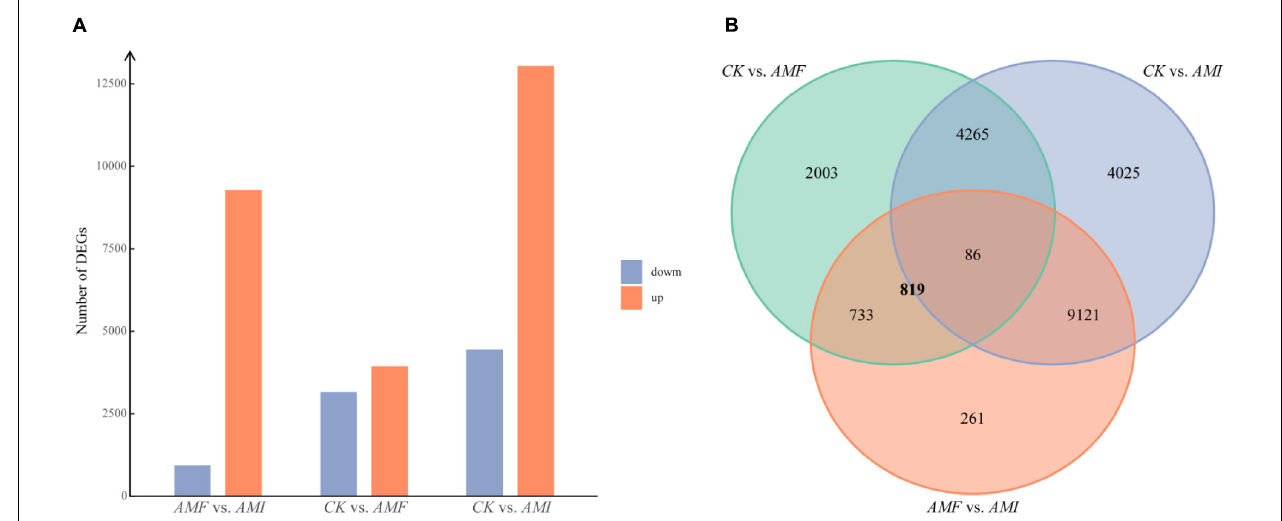
FIGURE 2 | (A) The number of DEGs identified in the pairwise comparisons among the three treatments. The thresholds are q < 0.01 and (cid:12) (cid:12) log 2 Fold Change (cid:12) (cid:12) > 1. The red and blue columns indicate the numbers of upregulated and downregulated genes in the pairwise comparisons, respectively. (B) Venn diagram of the pairwise comparisons among the three treatments. AMF vs. AMI indicates that compared with the AMI , the genes upregulated or downregulated in the AMF ; CK vs. AMI indicates that compared with the CK , the genes upregulated or downregulated in the AMI ; CK vs. AMF indicates that compared with the CK , the genes upregulated or downregulated in the AMF .